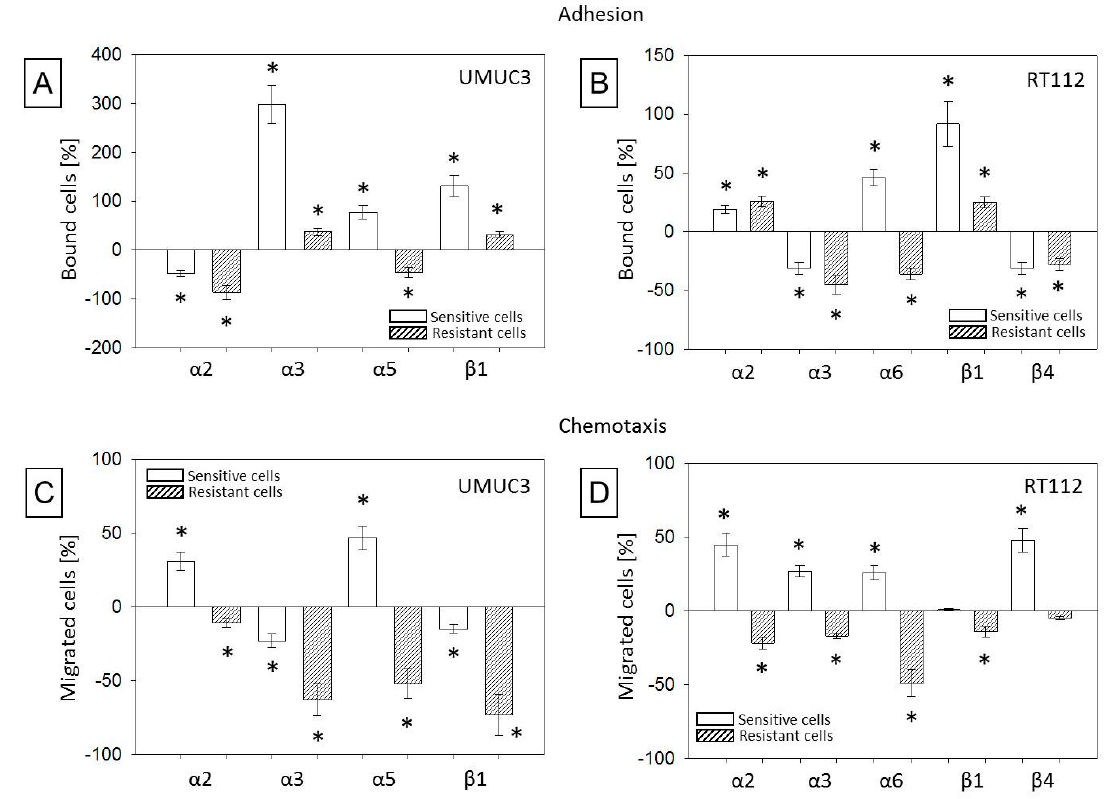
Figure 10. Influence of functional blocking of di ff erent integrin α and β subtypes on ( A ) UMUC3 and ( B ) RT112 cell adhesion to collagen as well as on ( C ) UMUC3 and ( D ) RT112 chemotaxis. Mean number of adherent or chemotactically active cells from five fields (0.25 mm 2 ) were evaluated and percentage of blocked bladder cancer cells compared to the unblocked corresponding control cells (set to 0%,) was calculated. Bars indicate standard deviation (SD), * indicates significant di ff erence to corresponding control, p ≤ 0.05. n = 5.